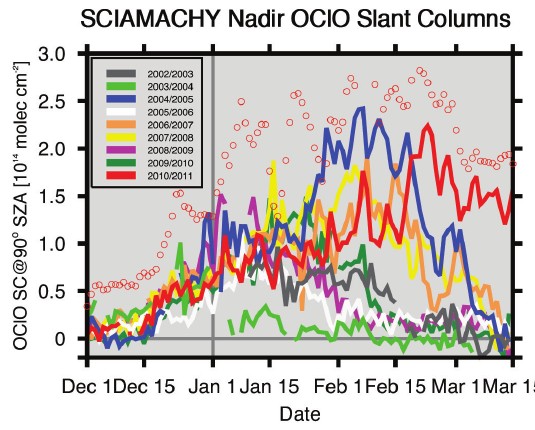
Fig. 10. SCIAMACHY nadir observations of OClO slant columns since winter 2002/2003 at 90 ◦ SZA. CTM calculations for winter– spring 2010/2011 are shown as red circles and were sampled at 90 ◦ SZA at the time of SCIAMACHY